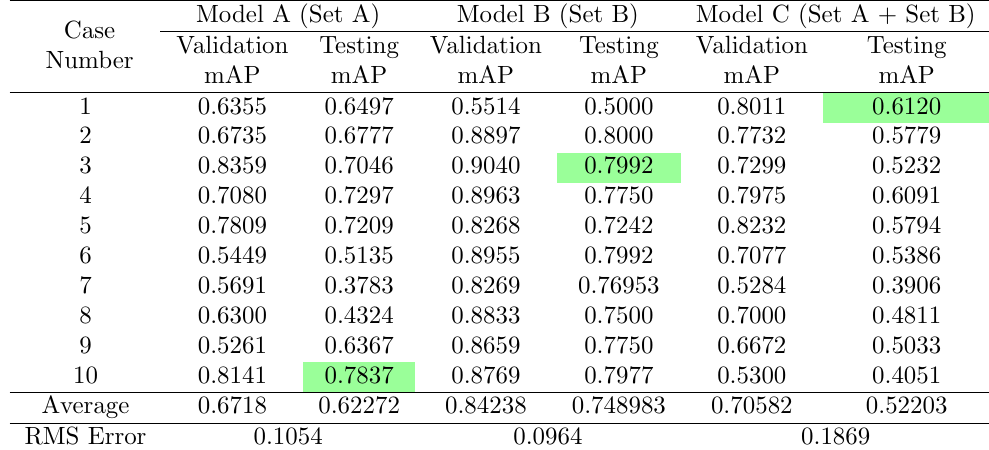
Table 4: Average precision obtained for different cases and models trained for Salmonids. The range of values goes from 0 (for a precision of 0%) to 1 (for a precision of